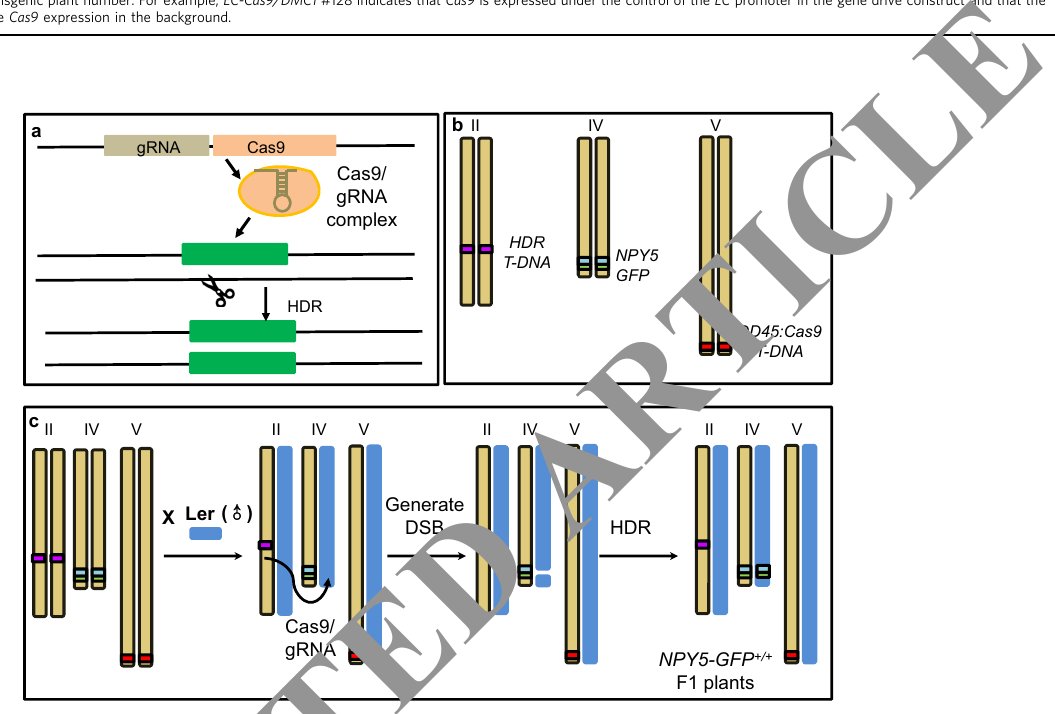
Fig. 4 Non-autonomous trans-acting gene drives in Arabidopsis . a A schematic representation of a non-autonomous trans-acting gene drive. A Cas9 unit and a gRNA unit are placed in a location far away from the target gene (on a different chromosome). The Cas9/gRNA complex cuts the wild type allele of the target gene. Subsequently, the DSB is repaired using the DNA from the homologous chromosome as the template, resulting in a homozygous plant. b The NPY5-GFP line can be used to test a non-autonomous trans-acting gene drive in Arabidopsis . The line contains an EC-Cas9 unit and a gRNA unit on Chromosome II while the target wild type NPY5 is on Chromosome IV. The NPY5 gene has been tagged with GFP . The DD45-Cas9 unit on Chromosome V may provide additional Cas9 for the non-autonomous trans-acting gene drive. c The functionality of the non-autonomous trans-acting gene drive was tested by crossing the NPY5-GFP line to wild type Ler. Cas9/gRNA from Chromosome II cuts wild type NPY5 , generating a DSB. The GFP and DNA fl anking GFP is used as a template for HDR, resulting in homozygous NPY5-GFP F1 plants.